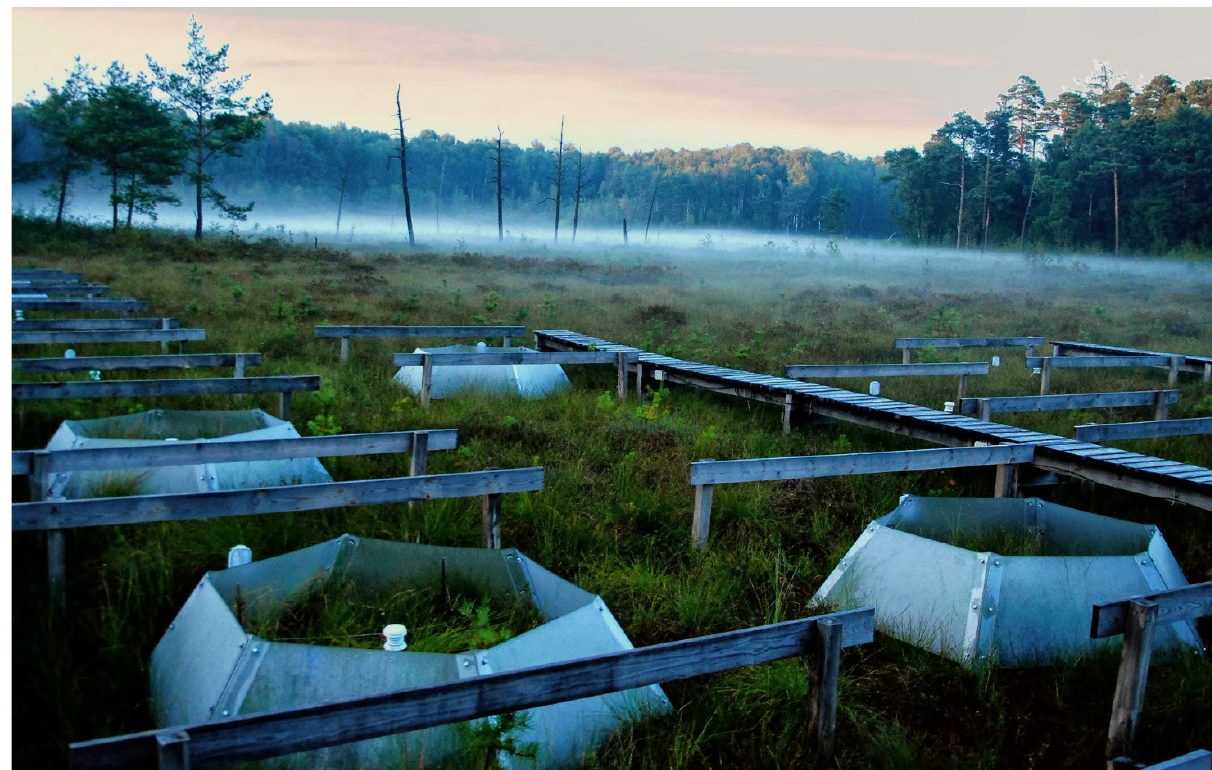
Figure 2. Linje Mire experimental site with open-top chambers passive heating system (photo Jan